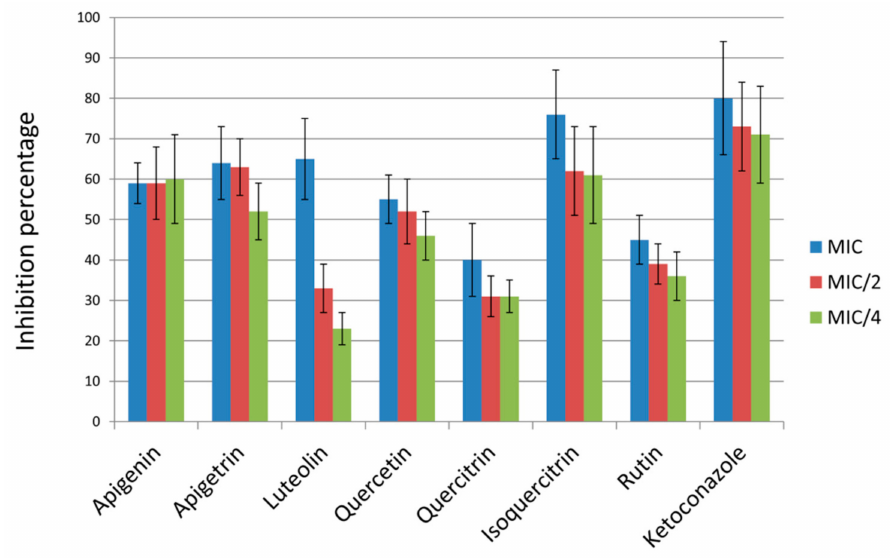
Figure 1. Percentage of inhibition of C. albicans biofilm formation after treatment with MIC and subMICs (MIC/2 and MIC/4) of compounds. Values are means ± SD of three replicates.